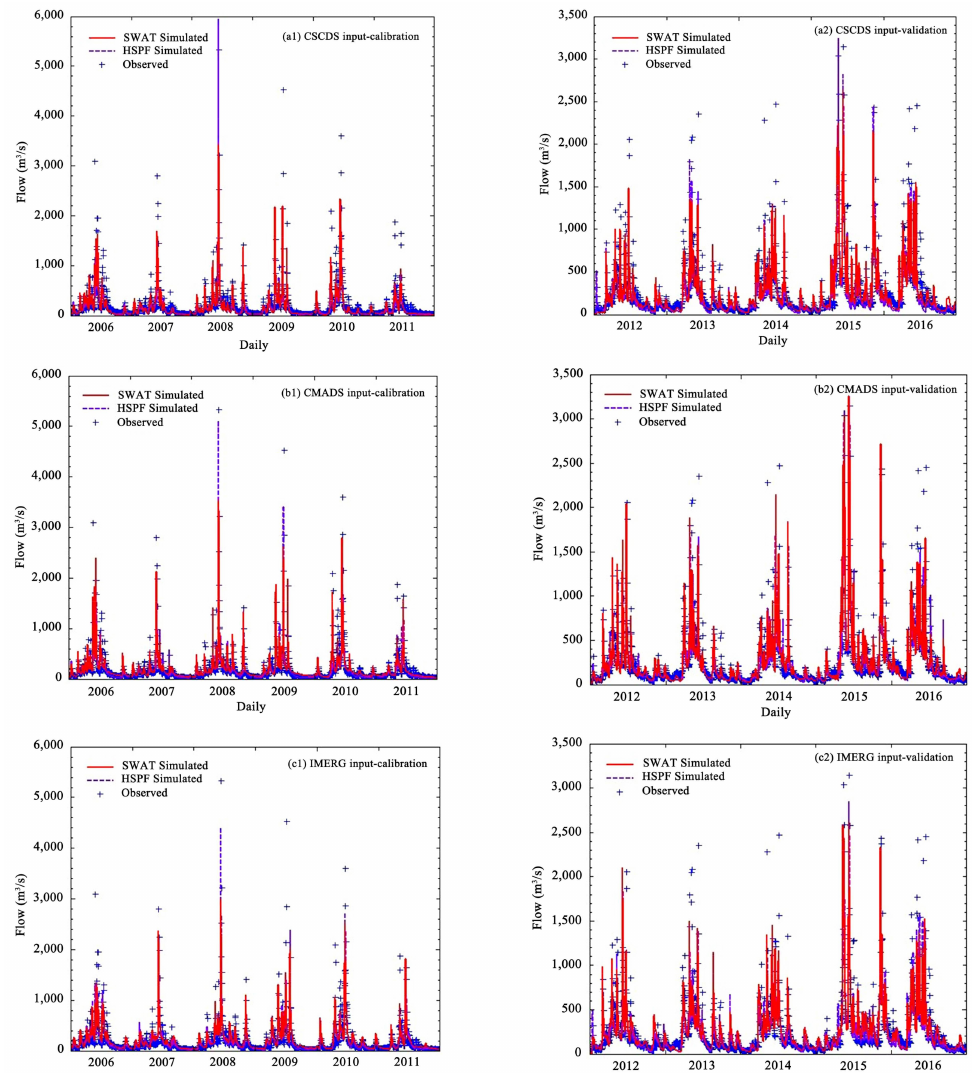
Figure 2. Comparison of the flow hydrograph results produced with the SWAT and HSPF model with ( a1 , a2 ) CSCDS, ( b1 , b2 ) CMADS, and ( c1 , c2 ) IMERG